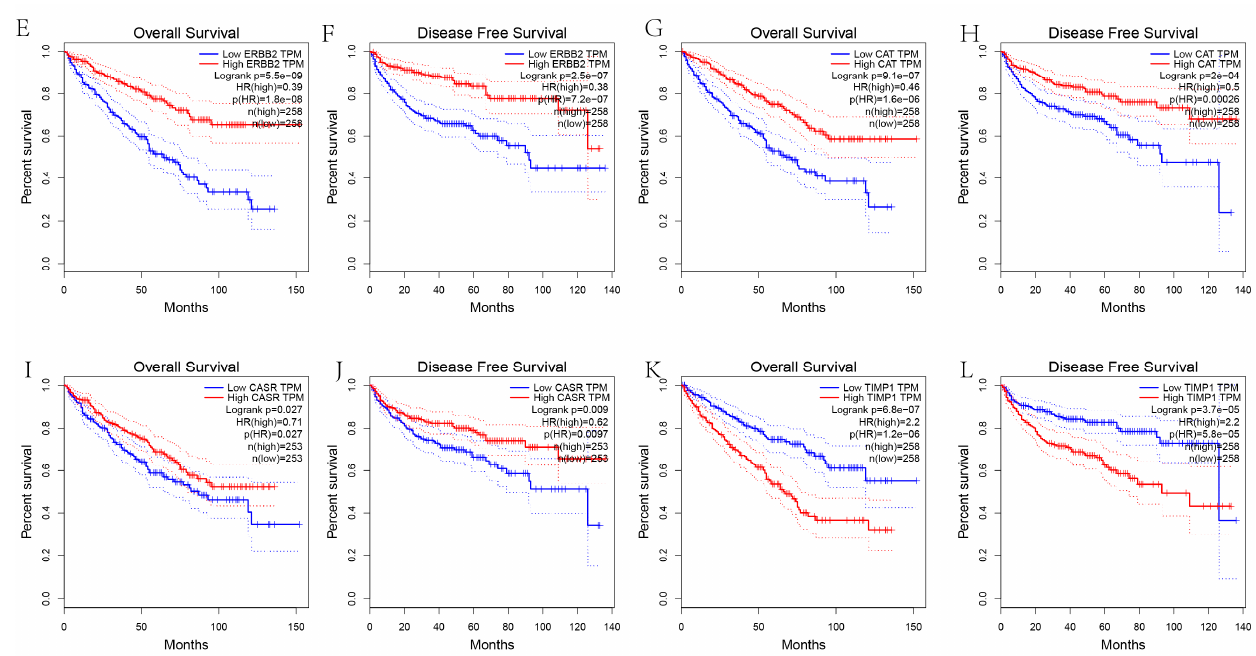
Figure 6. The overall survival and disease-free survival analysis of six hub genes using GEPIA.